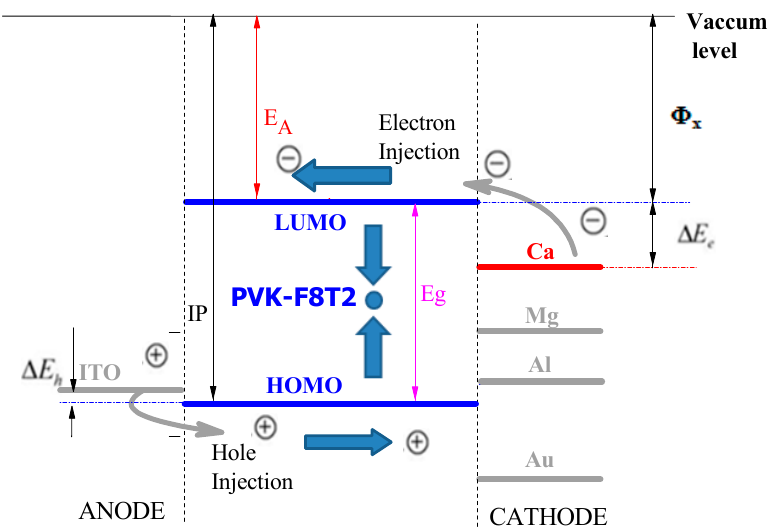
Figure 10. The active layer energy barriers with ITO/PEDOT:PSS/PVK-F8T2/Ca, Ag, Al, Au. (PE- DOT:PSS: Poly(3,4-ethylenedioxythiophene)-poly(styrenesulfonate)).